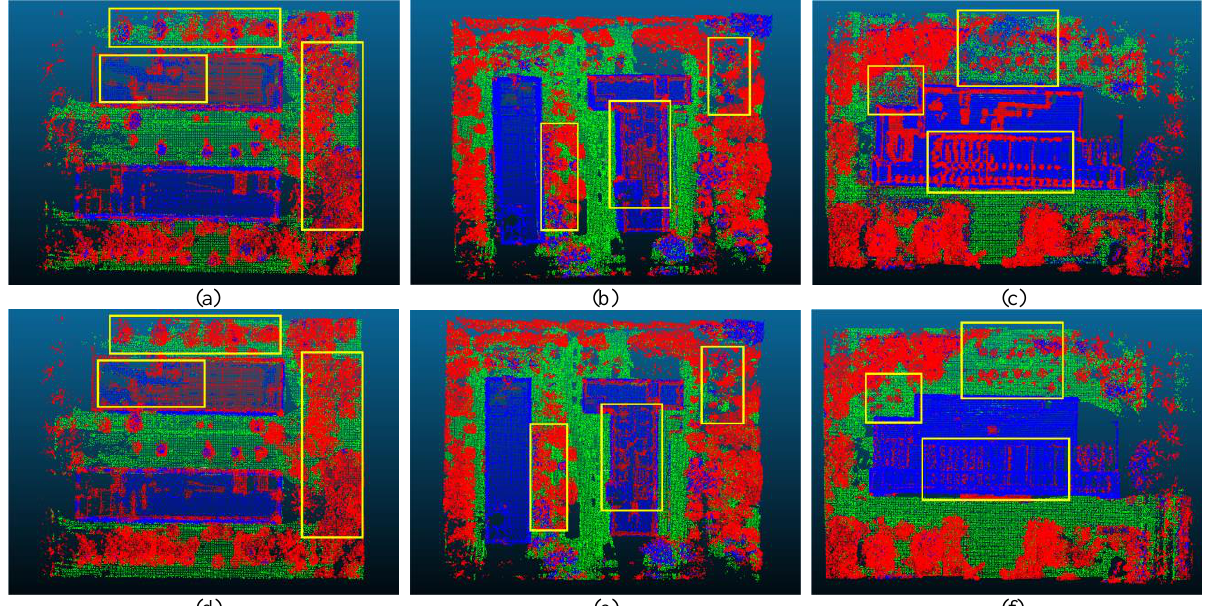
Figure 4. Point-based classification results. (a) - (c) are the results by using LiDAR points for scene II, III and I. (d) - (f) are the results by using LiDAR points and DIM points for scene II, III and I. Buildings, ground, and vegetation are colored in blue, green, and red.